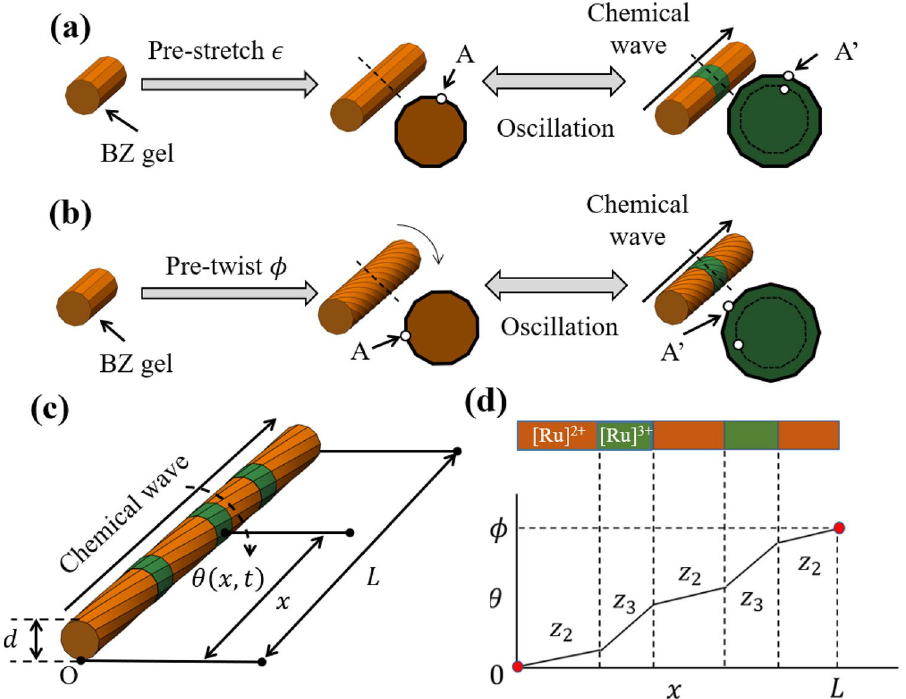
Figure 3. Schematics of the torsional motion of the BZ cylindrical gel with two fixed ends. ( a ) Pre-stretched BZ gel. ( b ) Pre-twisted BZ gel. ( c ) Notations of the pre-twisted BZ gel with wave propagation. ( d ) Schematics of the one-dimensional (1D) twist gel model. The graph depicts θ( x ) at a certain